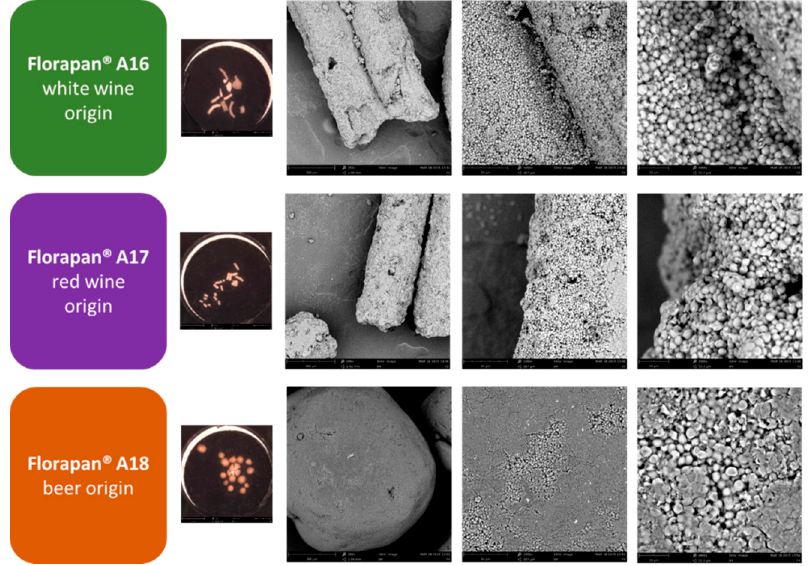
Figure 1. The SEM images of the active dry yeast surface for the commercial preparations Florapan ® A16 (A16), Florapan ® A17 (A17), and Florapan ® A18 (A18). Each preparation was visualized with an optical camera (~20X) (small colored image on the left) and with scanning electron microscope (SEM) (~250X, ~1500X, ~5000X) (grey images).